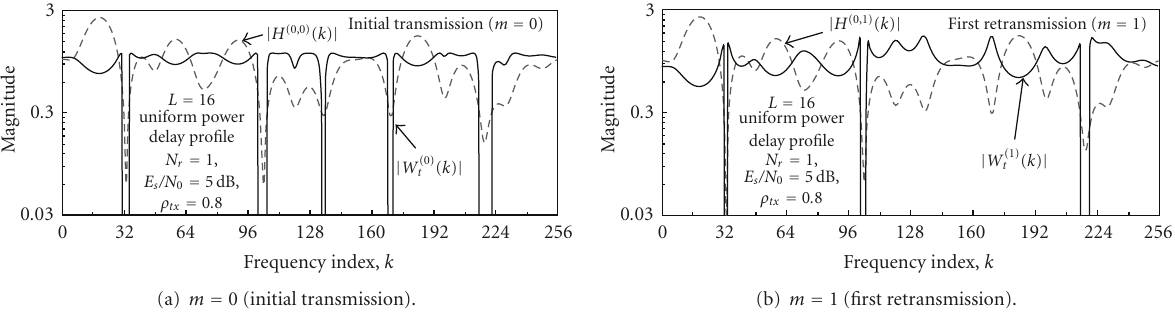
Figure 4: Channel transfer function and Tx MMSE-FDE weight for channel case